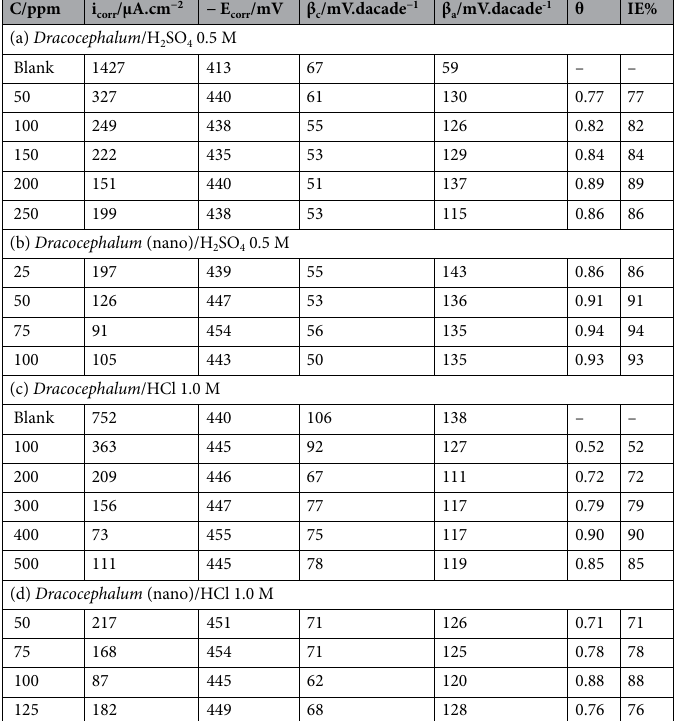
Table 4. Corrosion parameters derived from polarization curves for st-37 in sulfuric acid solution with (a) inhibitor, (b) nano inhibitor, and in hydrochloric acid solution with (c) inhibitor, (d) nano inhibitor in uninhibited, and inhibited solution at 25 ± 1